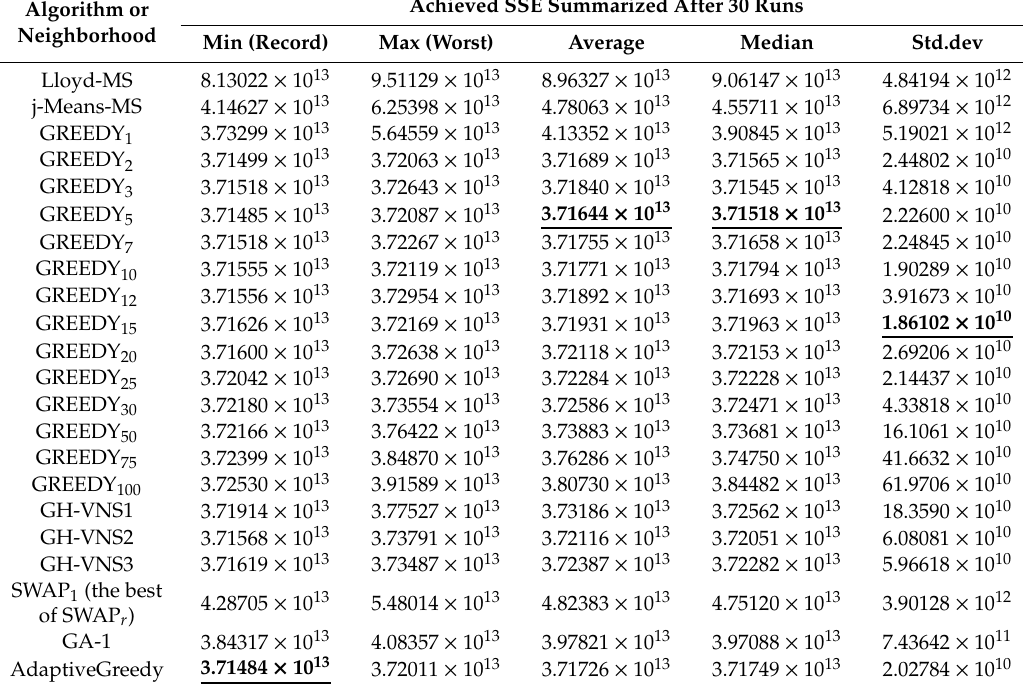
Table A6. Comparative results for BIRCH3 data set. 10 5 data vectors in R 2 , k = 100 clusters, time limitation 10